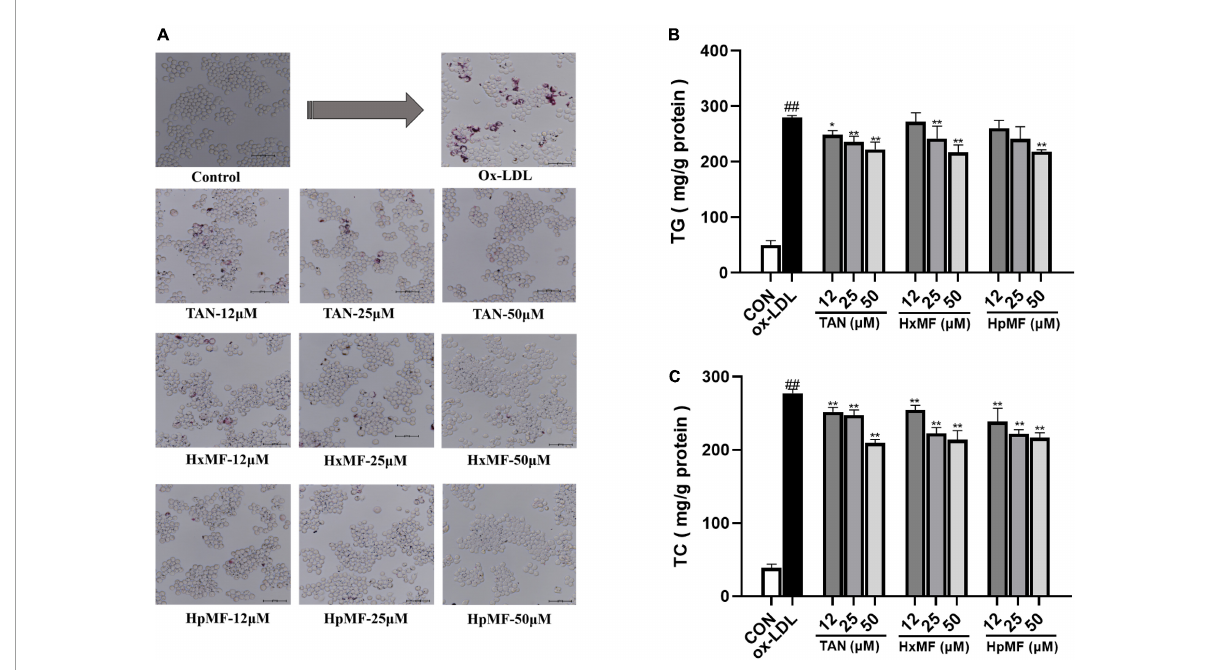
FIGURE3 Effects of TAN, HxMF, and HpMF on ox-LDL-induced lipid accumulation by Oil Red O staining (A) ; effects of TAN, HxMF, and HpMF on triglyceride (TG) (B) and total cholesterol (TC) (C) contents in ox-LDL-induced RAW264.7 cells. All experiments were run in triplicate, and data showed mean ± SD. ## p < 0.01 compared with the control group, * p < 0.05 and ** p < 0.01 compared with the ox-LDL group.